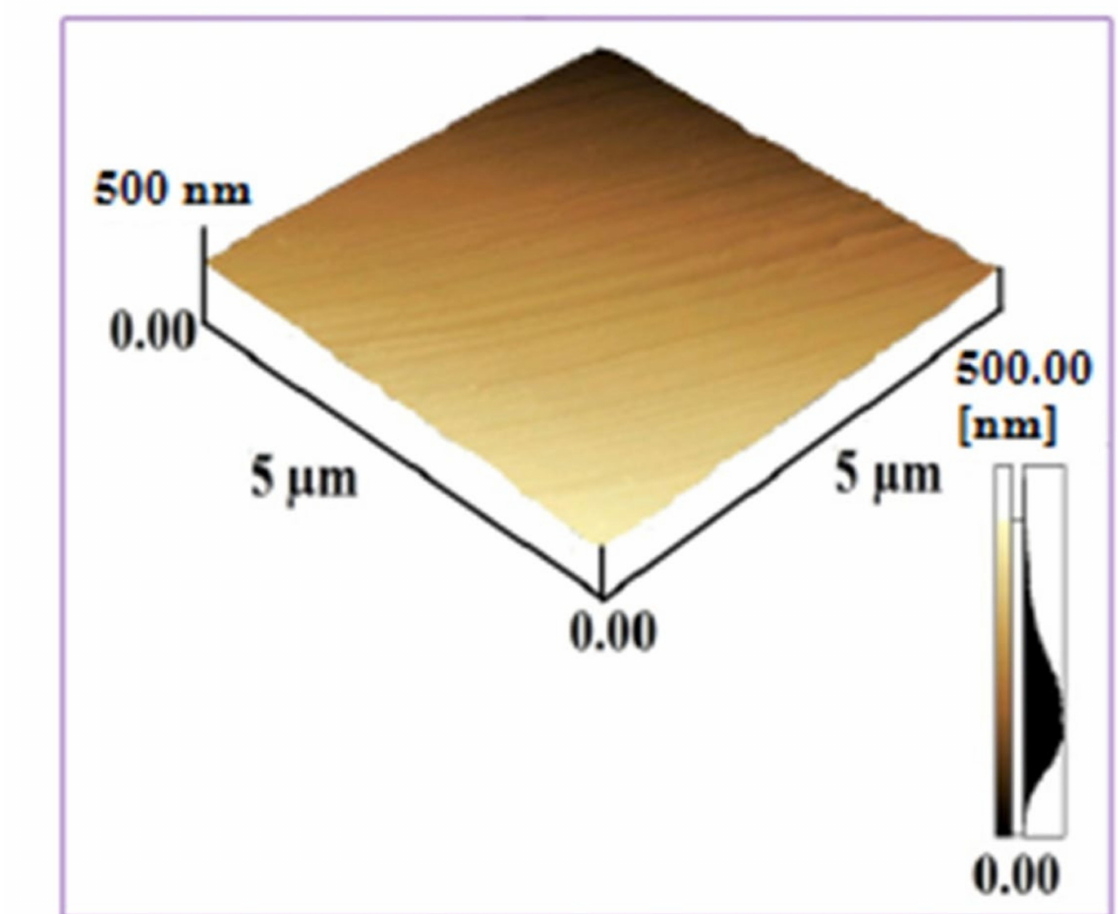
Figure 5. AFM surface topographical image of untreated Al surface for scan area 5 µ m × 5 µ m. Figure 6a,b depicts the AFM surface topographies of Al targets of 5 µ m × 5 µ m scan area, exposed to 100 laser pulses at a pressure of 100 torr for 0.86 J · cm − 2 fluence in Ar